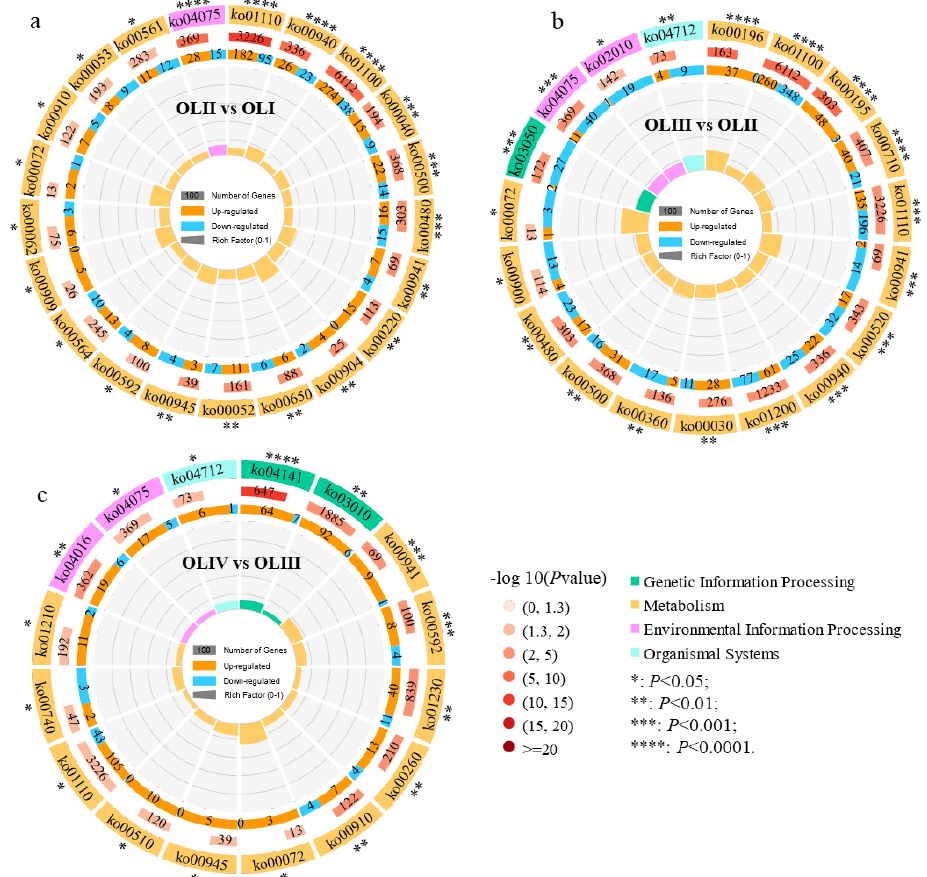
Figure 6. Significantly enriched KEGG pathway in diverse pairwise comparisons ( a – c ) ( p value < 0.05).